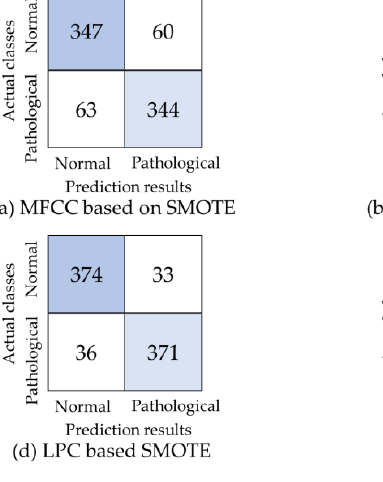
Figure 8. The confusion matrices obtained by the FNN on the class-balanced dataset under various conditions.